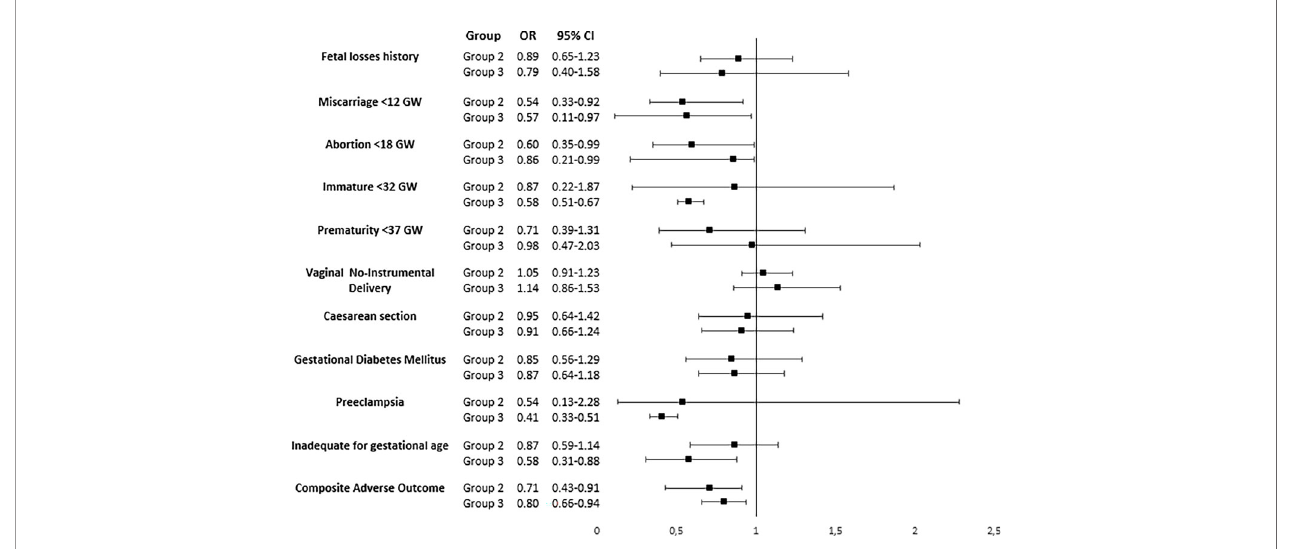
FIGURE 1 | Odds ratio (95% con fi dence interval) adjusted for age, parity, and smoking habit to receive levothyroxine treatment before week 9th of gestation compared to receiving it later or not to receive it as the reference group, by groups. Composite Adverse Outcomes: pre-eclampsia, GDM, fetal loss, immature and/or premature newborn, C-section, and newborn of inadequate weight for Gestational